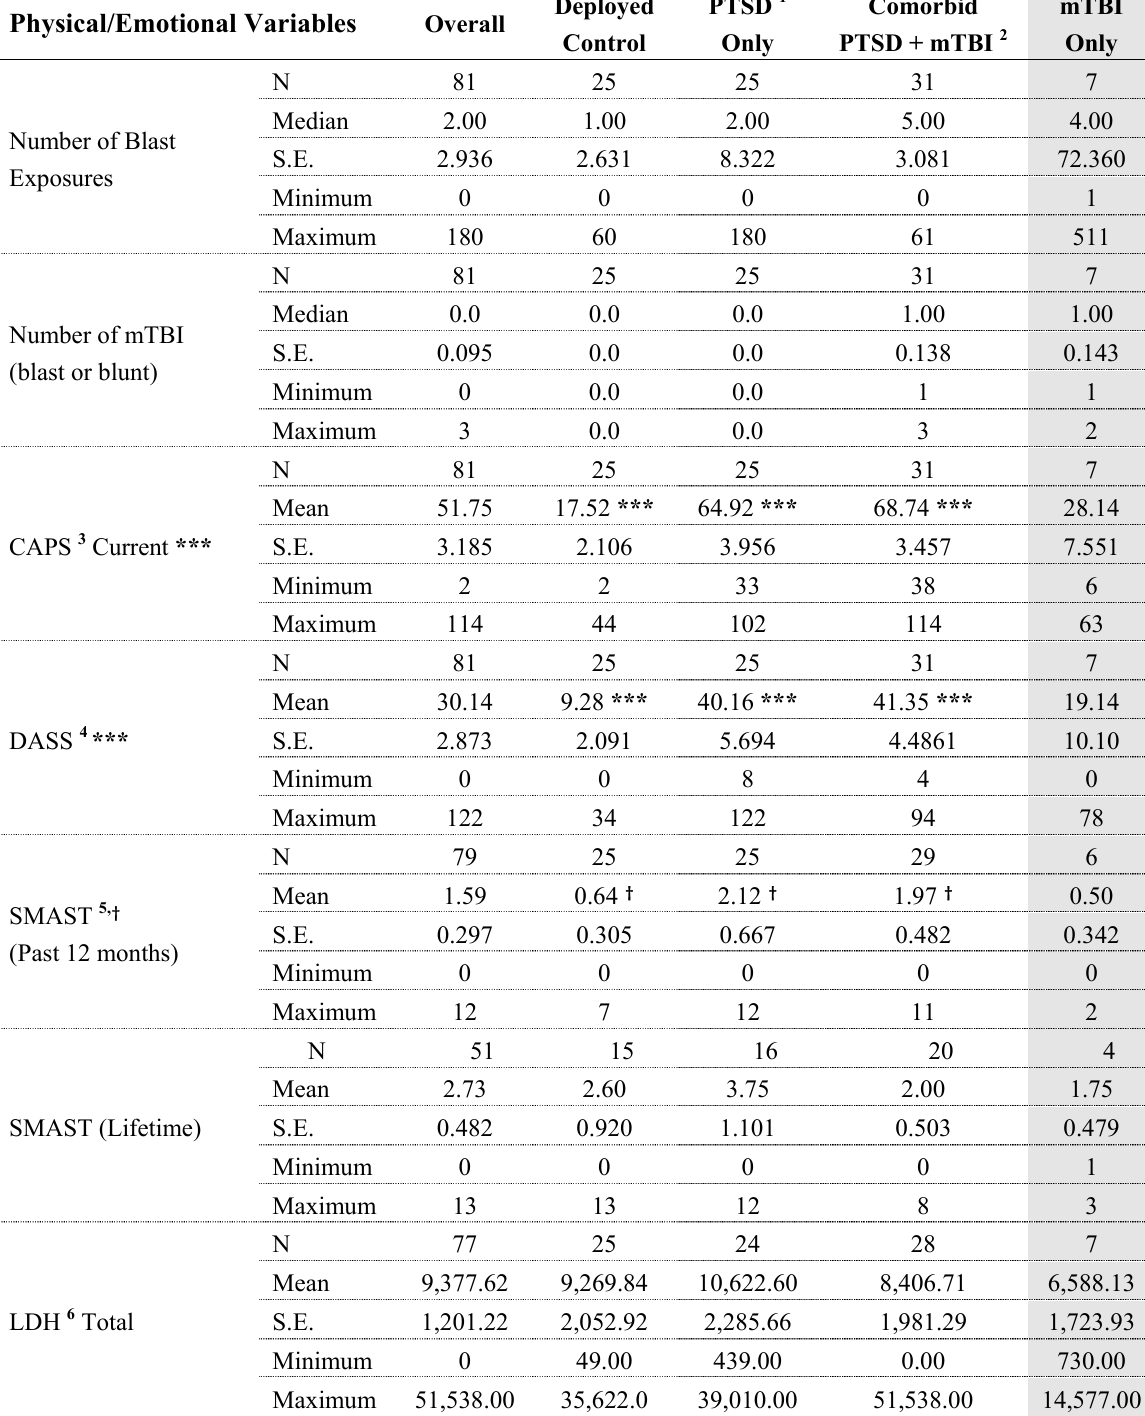
Comorbid mTBI Deployed PTSD 1 Only PTSD + mTBI 2 Control Only